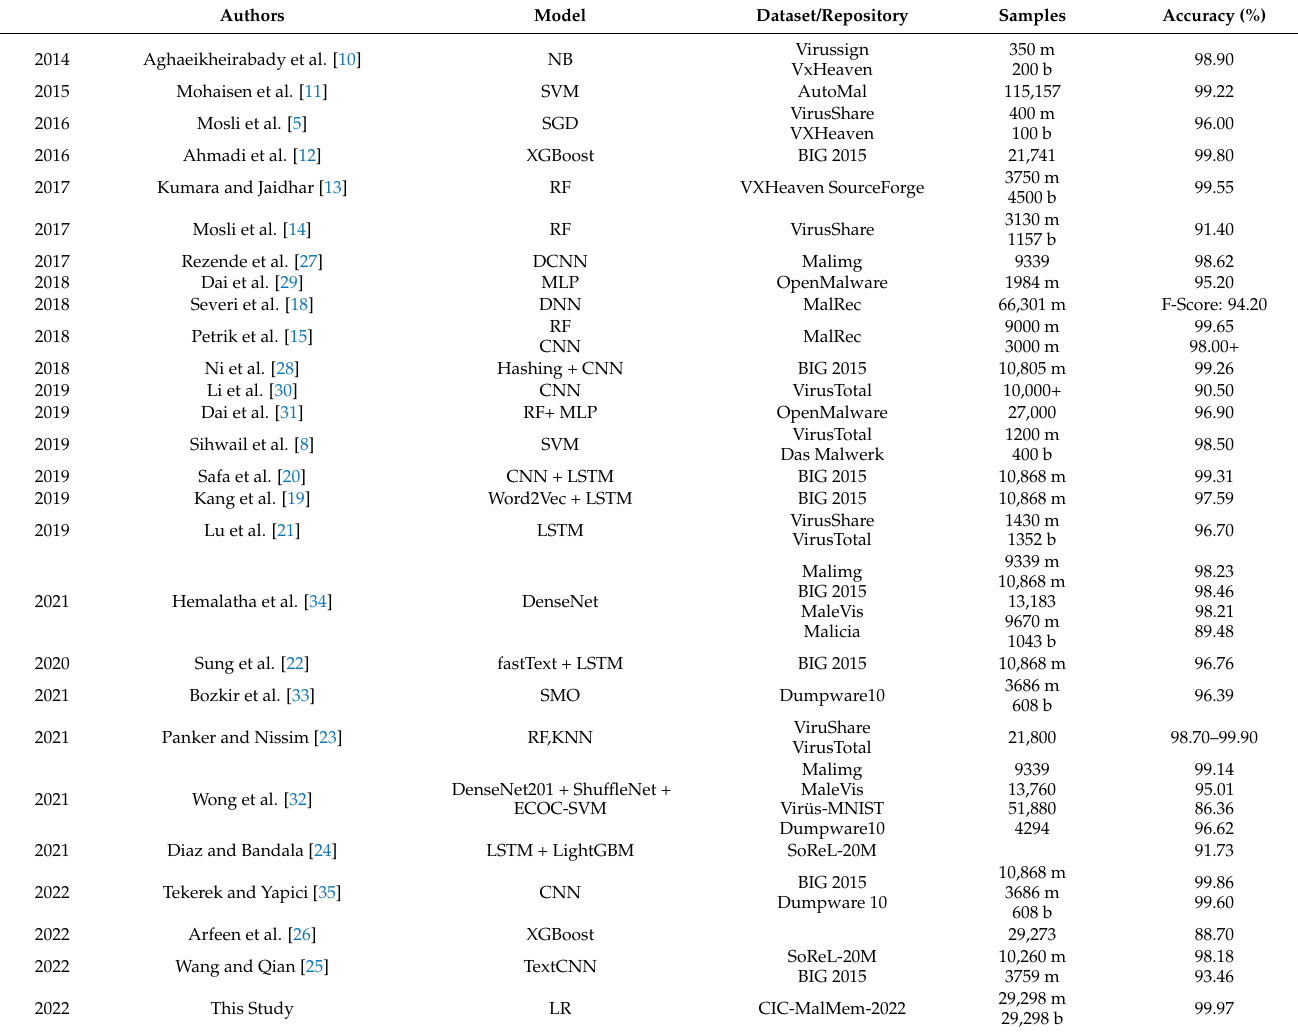
Table 1. Comparison of other works on Malware